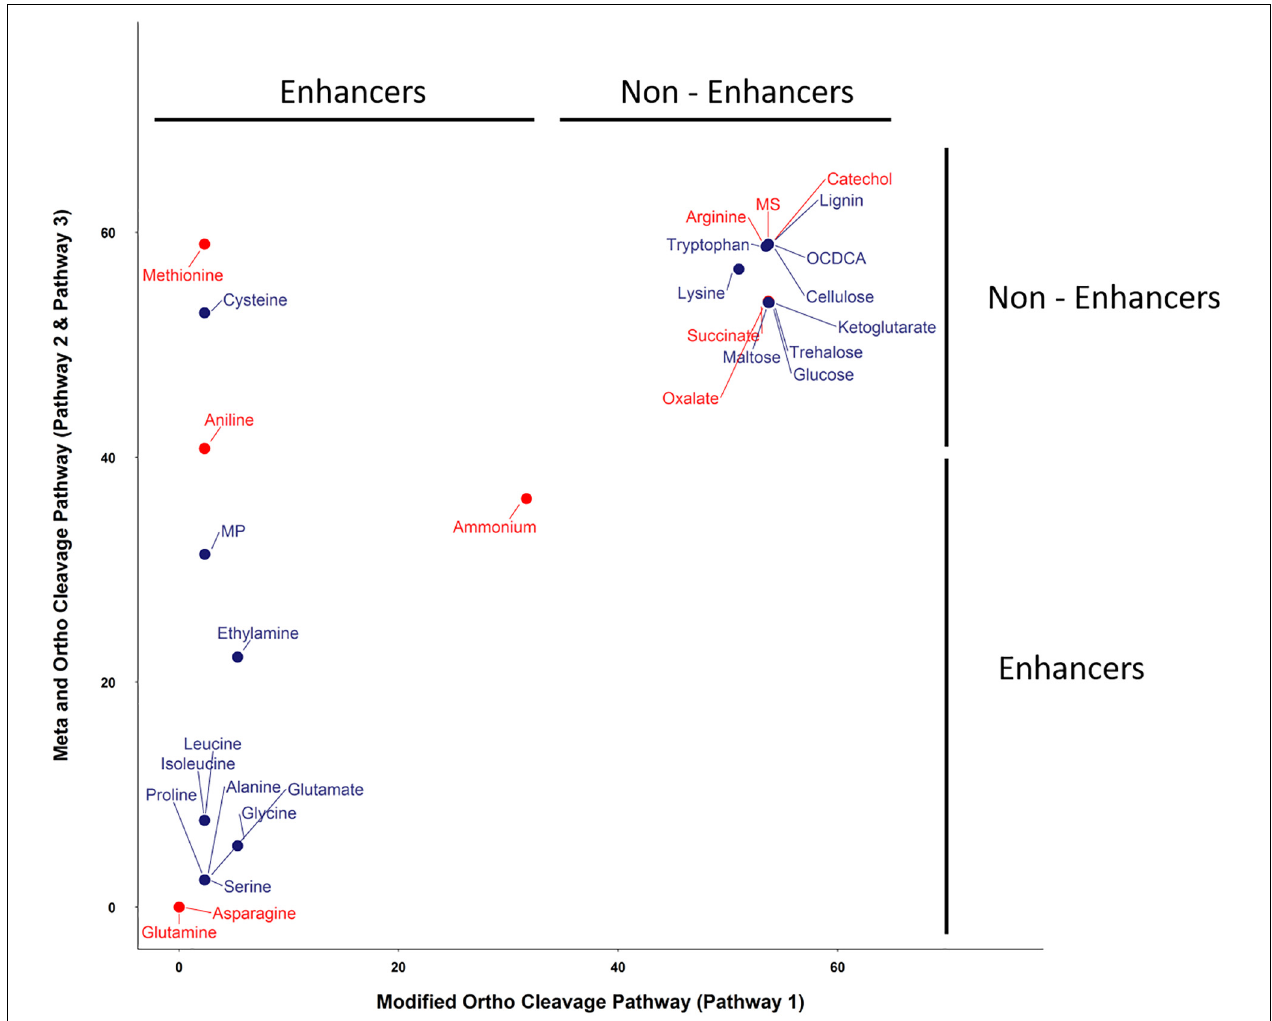
FIGURE 4 | Linuron degradation status (at round 10) under the influence of supplements with the ortho- and meta-cleavage pathway (Pathways 2 and 3) vs. the modified ortho-cleavage pathway (Pathway 1). Substrates in red were selected for further validation in the lab experiment. The x and y scales represent the amount of linuron